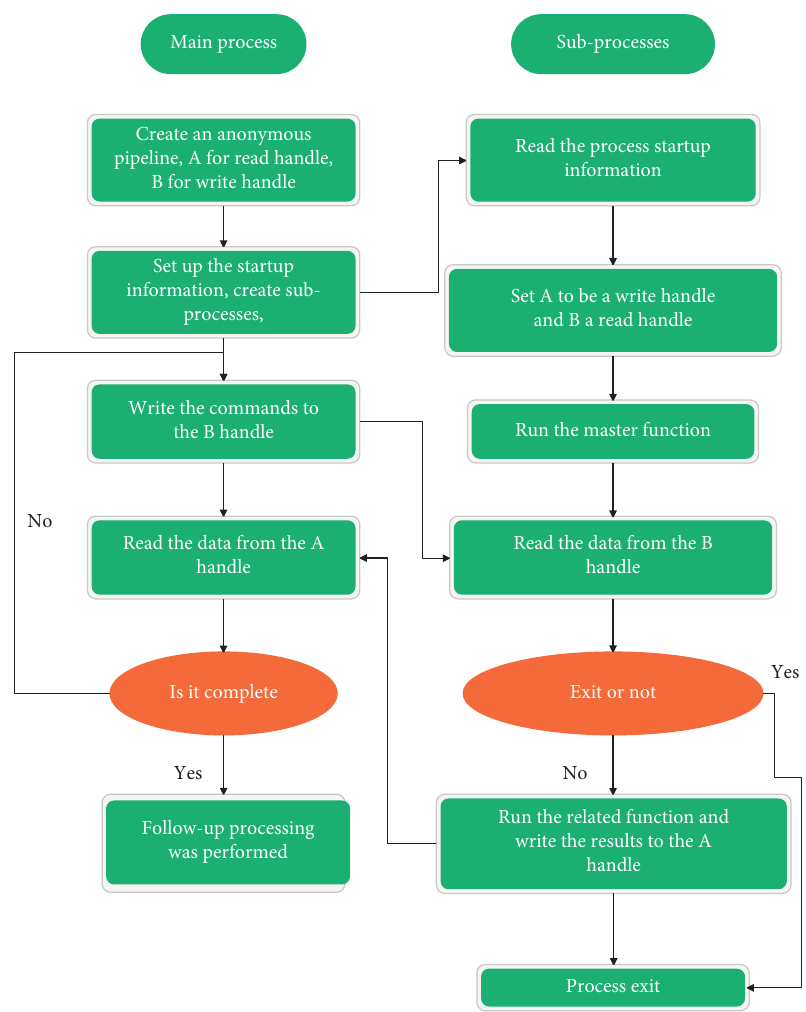
Figure 8: Calling of subroutines of the spoken pronunciation evaluation engine for AI virtual English reading. Table 2: Performance evaluation of the correction system of spoken pronunciation accuracy of AI virtual English reading.